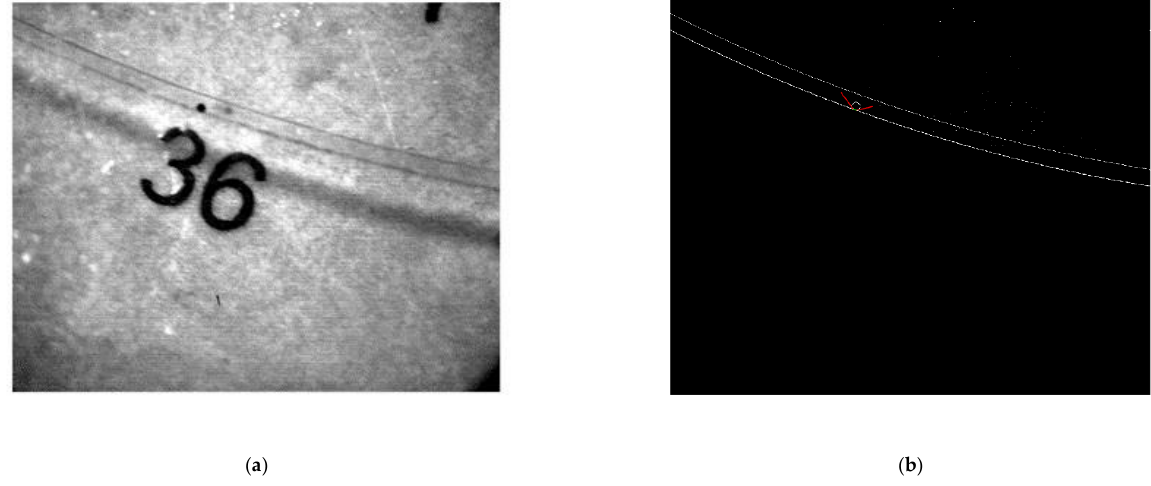
Figure A2. ( a ) Original image of droplet flow; ( b ) the droplet image processed by MATLAB